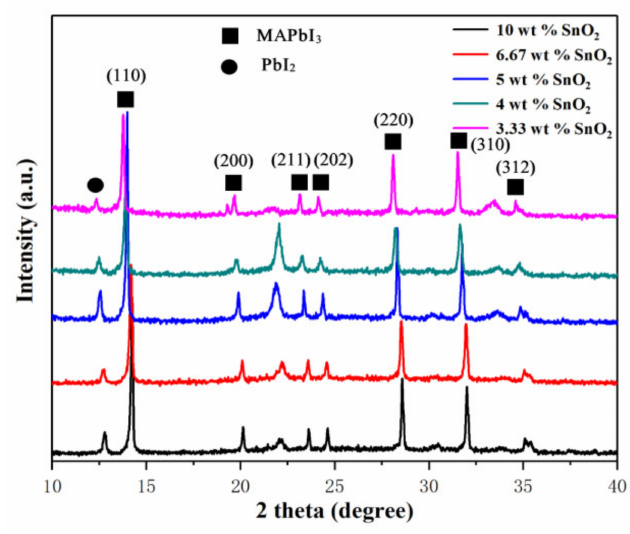
Figure 2. XRD patterns for perovskite films deposited on various SnO 2 layers. Table 1. The relative intensity ratio of the PbI 2 peak and (110) of MAPbI 3 with XRD patterns of perovskite film.